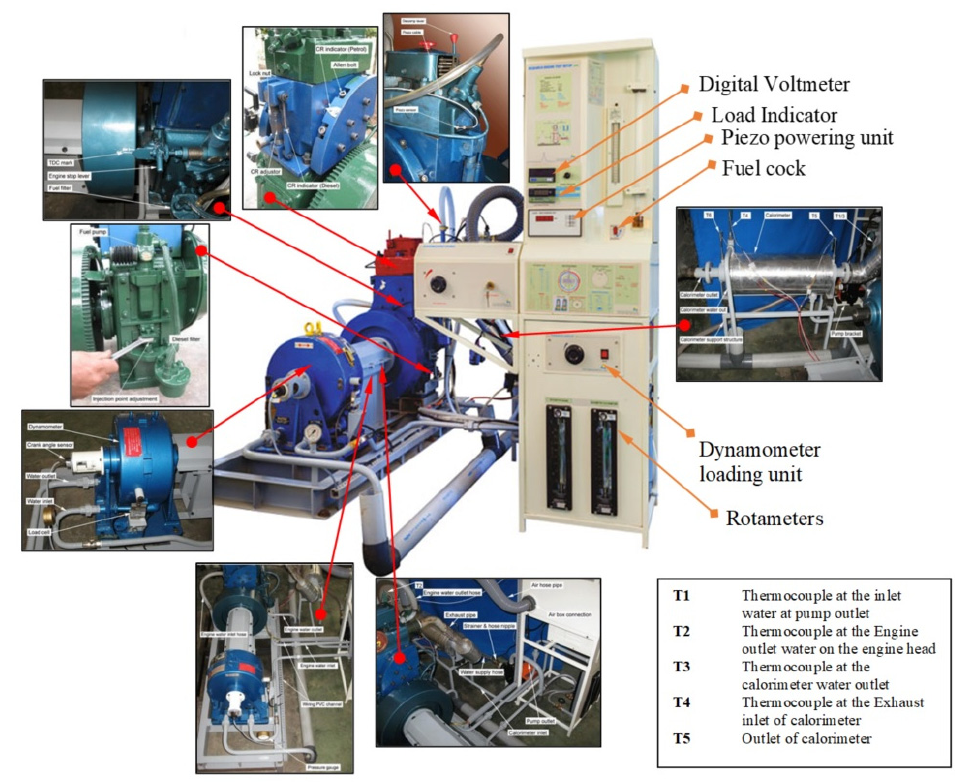
Figure 7. Variable Compression Ratio (VCR) diesel engine. Table 2. Engine specifications.